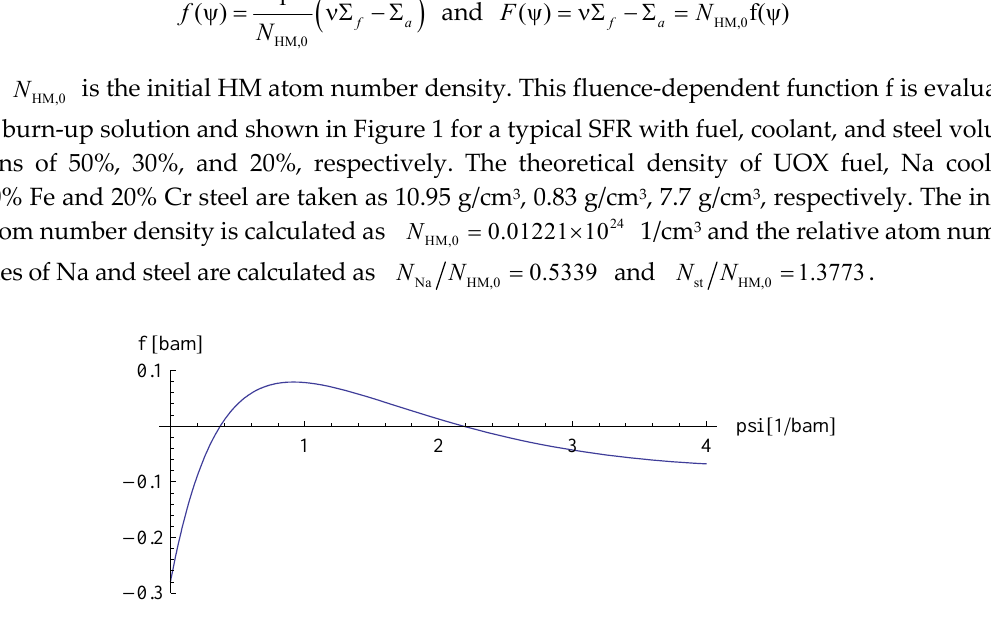
Figure 1. The mean microscopic net neutron generation cross section f as function of ψ